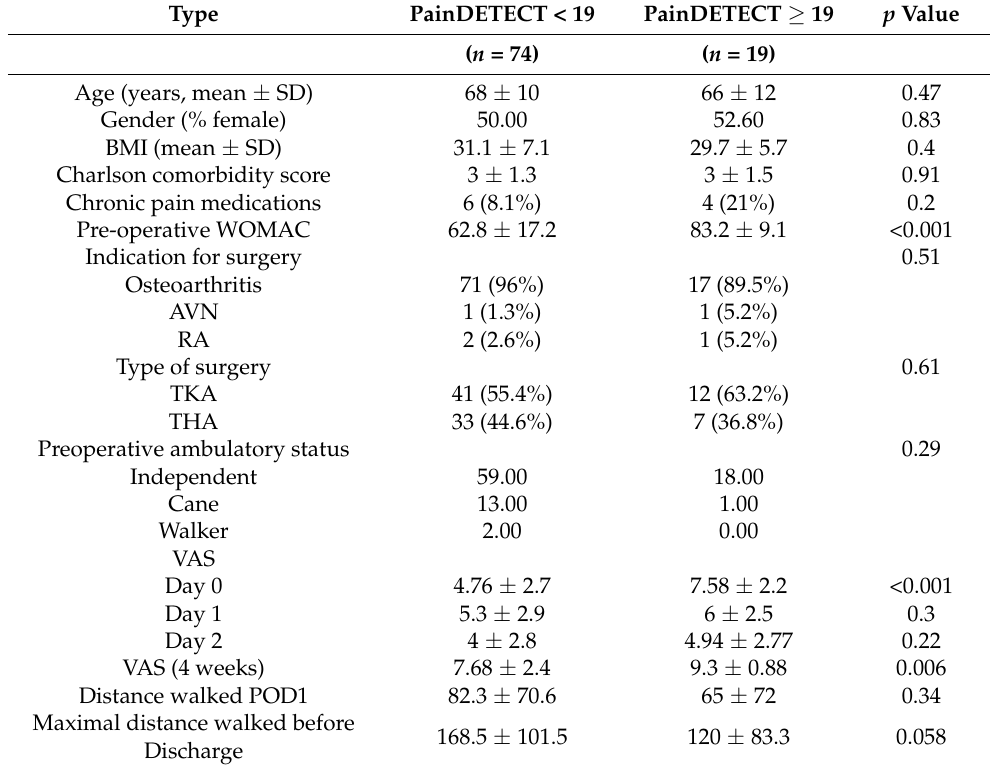
Table 2. Pre- and postoperative characteristics of patients with and without neuropathic